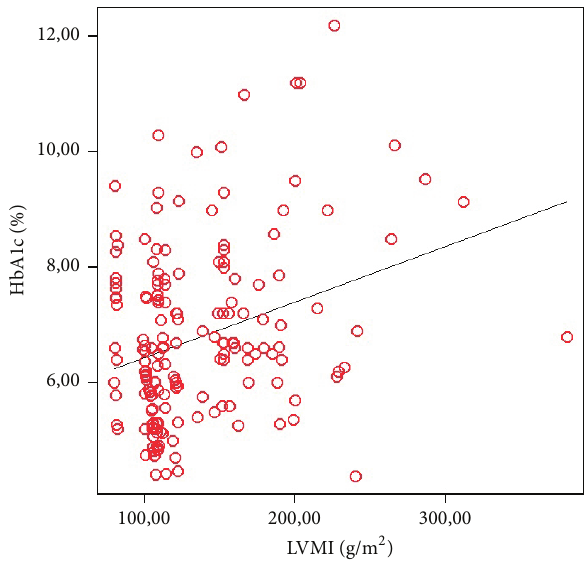
Figure 1: Linear regression analysis of factors affecting left ventric- ular mass revealed that HbA1c was the major determinant of LVMI ( 𝑃 : 0.026, 𝛽 :